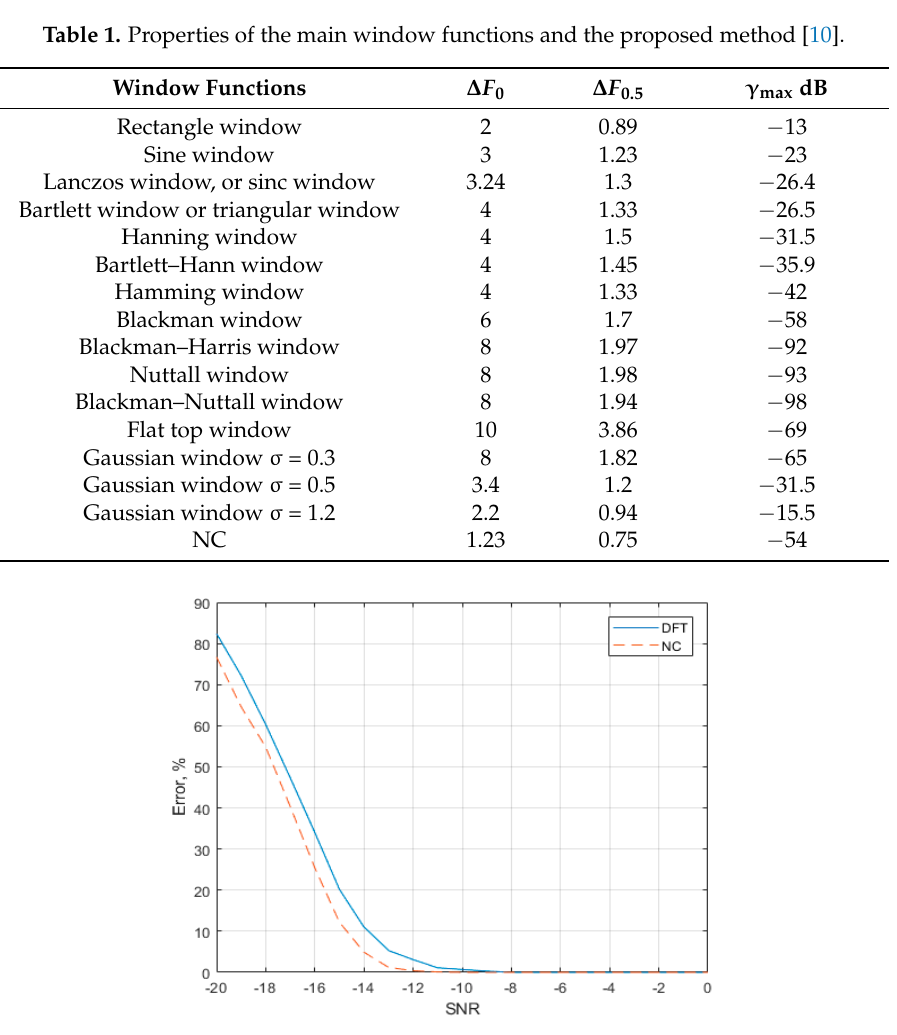
Figure 12. Comparison of mono-harmonic signal detection using DFT and NC.